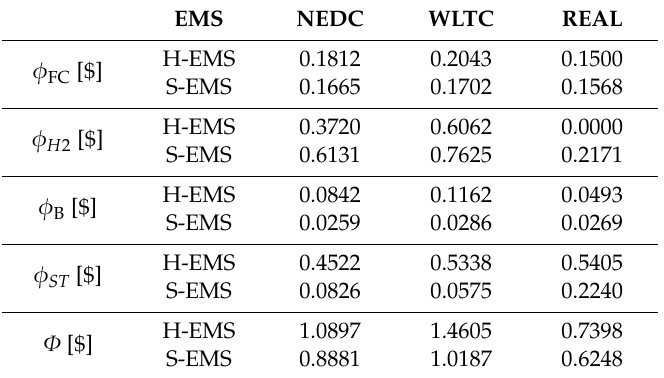
Figure 21. Performance comparison between H-EMS (blue bars) and S-EMS (red bars) in terms of cost function contributions over different driving cycles. Table 1. Cost function values (H-EMS and S-EMS).